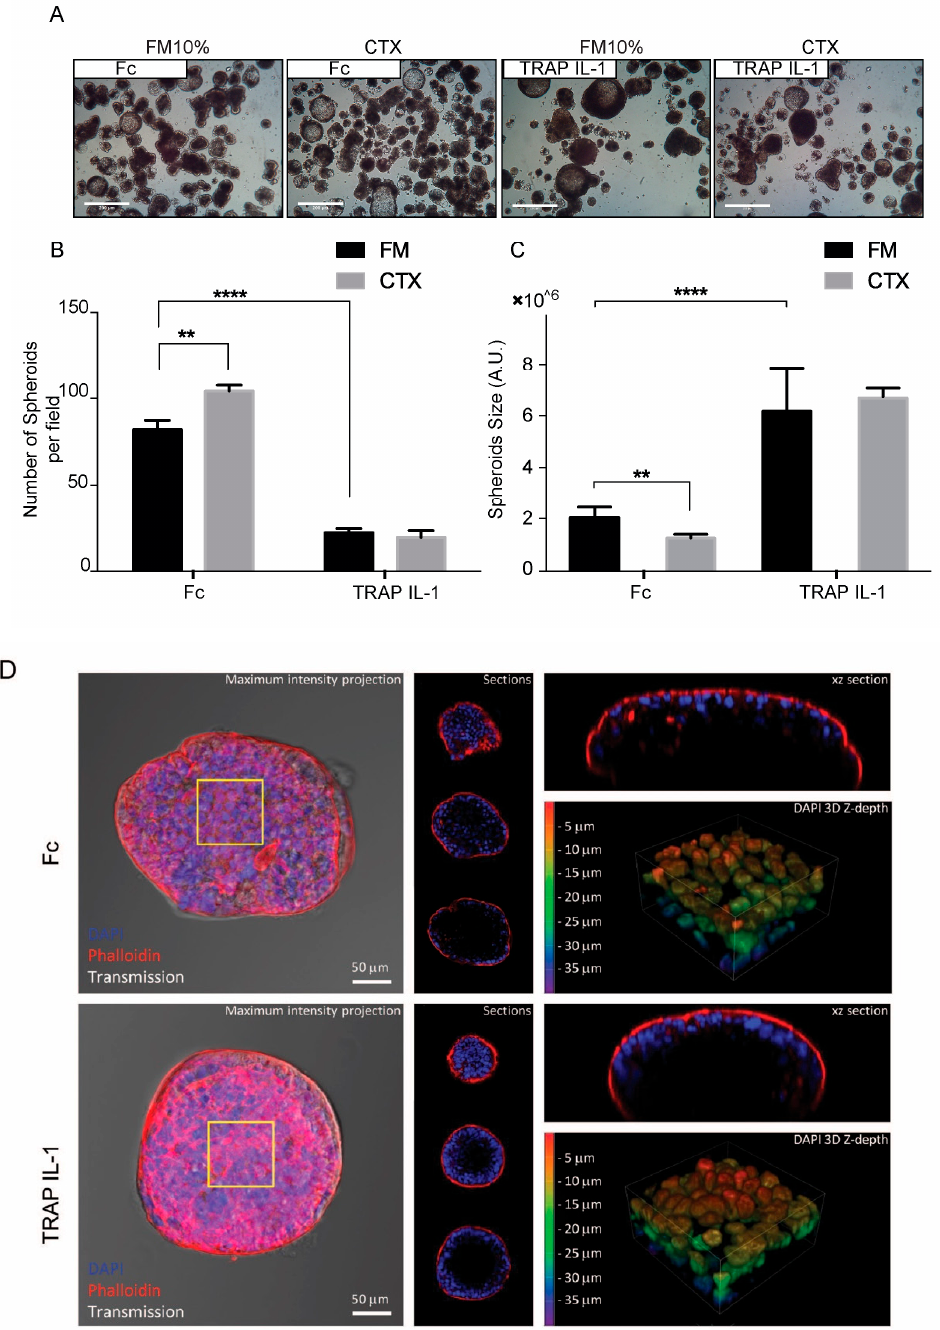
Figure 3. Caco-2 TRAP IL-1 display decreased growth in suspension as colonspheres. ( A ) 4 × magnification of Caco-2 Fc and Caco-2 TRAP IL-1 producing “spheroid-like” structures, under the indicated treatments. Scale bar 100 µ m. ( B ) Number of filled spheroids presented as average ± S.E.M. 2-way ANOVA with Bonferroni Test, ** p < 0.01; **** p <0.0001; ( C ) Quantification of spheroid size measurements under the indicated treatments in 10% FBS medium supplemented with EGF 10 ng/mL and CTX 5 µ g/mL. Columns represent volume averages ± S.E.M, 1-way ANOVA, ** p < 0.01; **** p < 0.0001. ( D ) 3D confocal microscopy of colonspheres Fc and TRAP IL-1. In the left panel is reported the DAPI and phalloidin staining. In the middle panel are featured single optical sections collected at 15 µ m intervals. In the panel on the right, the xz optical section passing through the maximum diameter of the spheroids (upper part) and 3D rendering focused on the nuclear density and z-depth of the spheroids (yellow square), reported as a scale of colors, red indicates a 5 µ m depth and blue 35 µ m depth (bottom